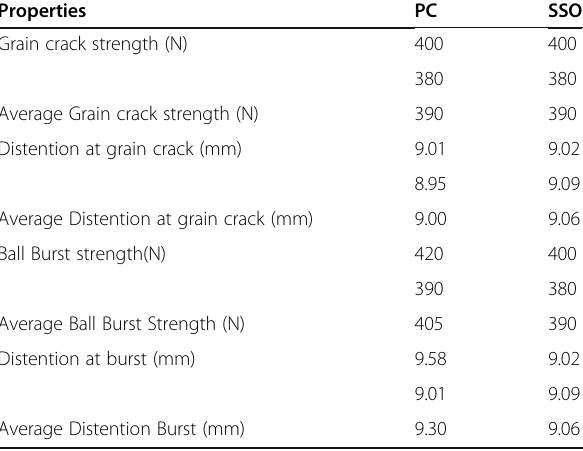
Table 8 Strength of Grain Surface of Leather Test Pieces